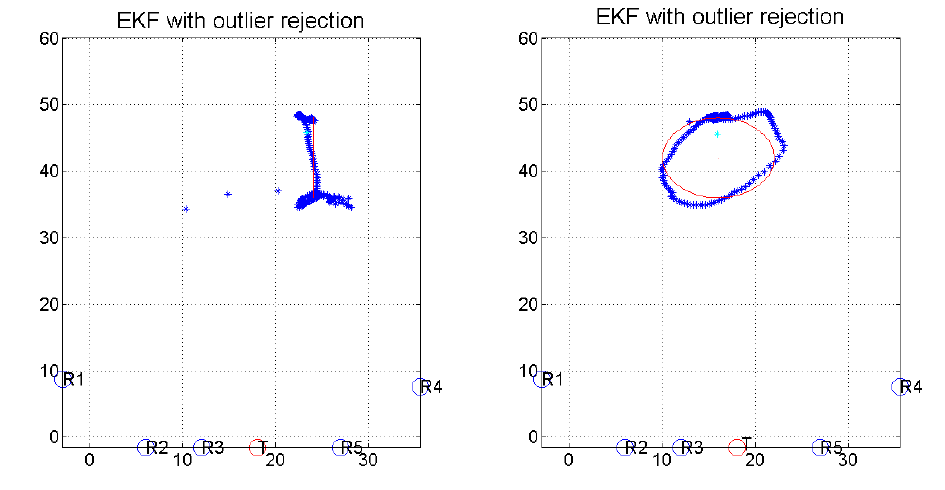
Figure 15. ( Left ): The target moves from (20, 36) to (20, 48), the velocity in the y -direction is about 1 cm/s; ( Right ): The target moves in a circle with center at (16, 42), both the start point and the end point are at (16, 48). (Blue dots: the estimated coordinates of moving target; red line: the reference target